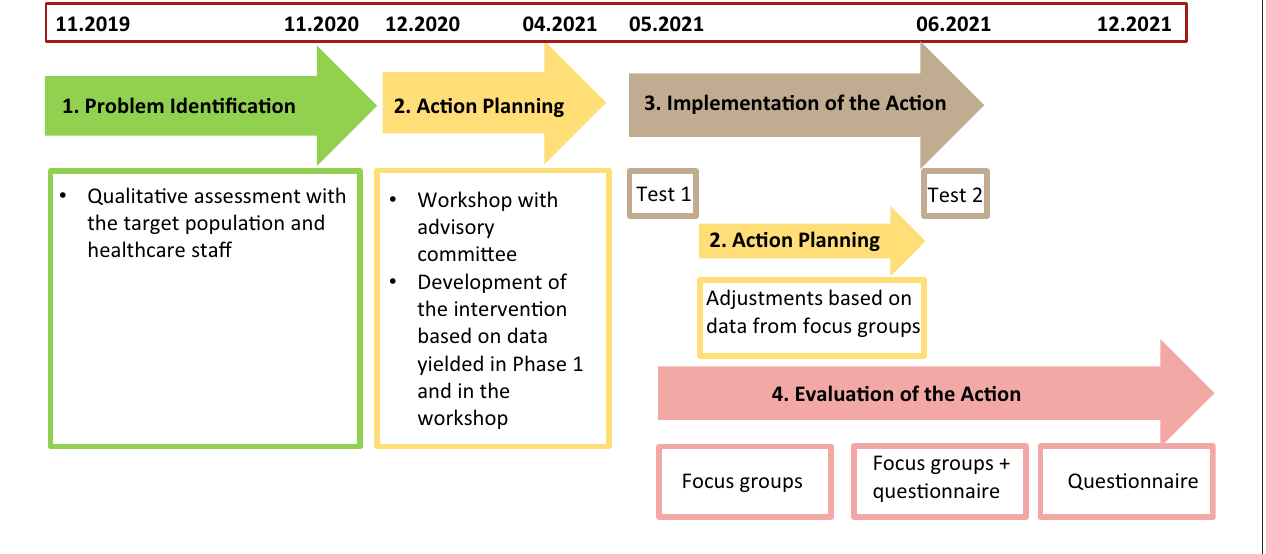
FIGURE 1 | Research project timeline by research action